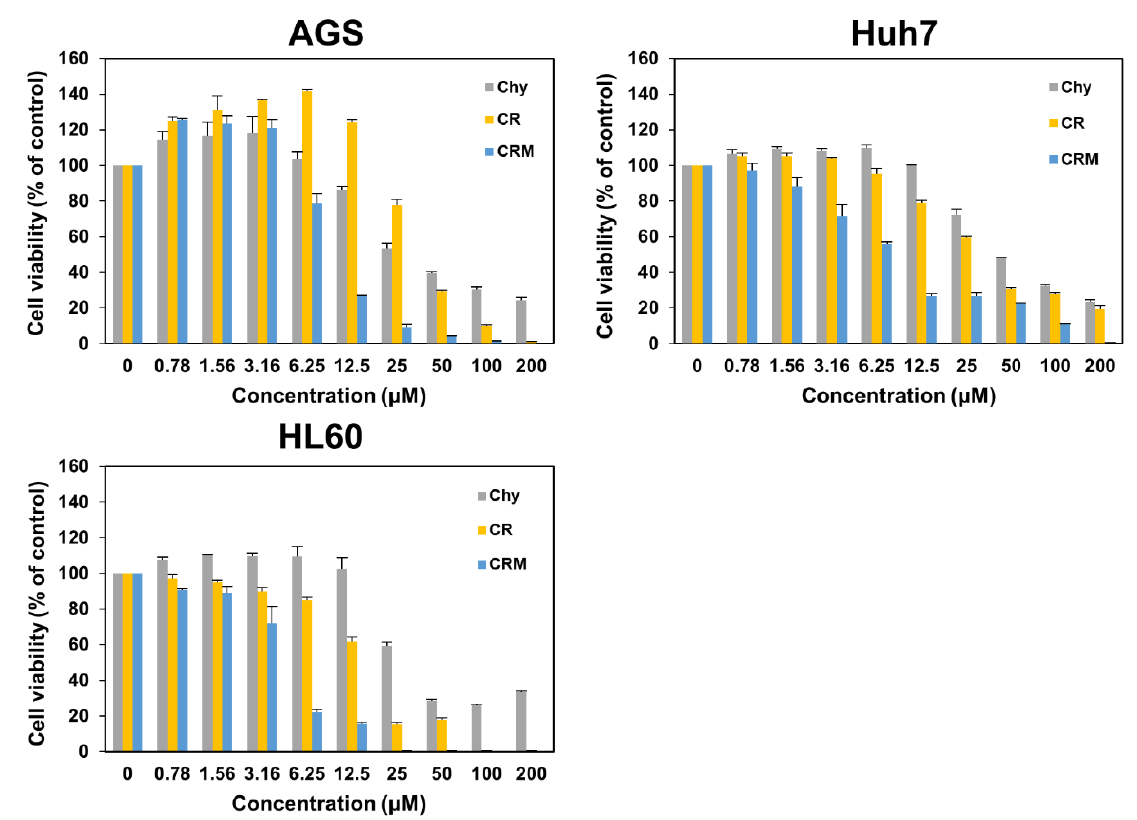
Figure 4. Cell cytotoxicity assay results of chrysazin, chrysazin-8- O - α - L -rhamnoside, and chrysazin- 8- O - α - L - 2′ - O -methylrhamnoside. Cells were treated with various concentrations (0.0 –200 μM) of each compound.